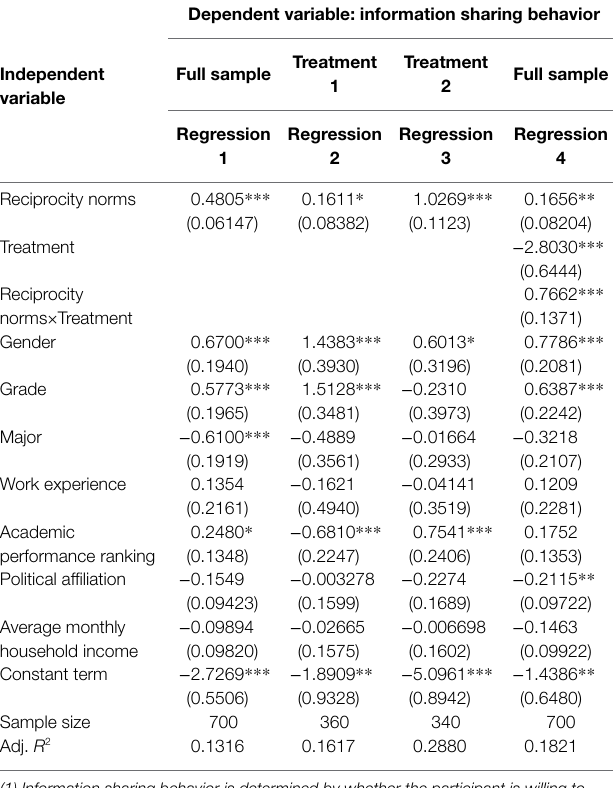
TABLE 5 | Relationships between feedback and information sharing behavior and information accuracy.